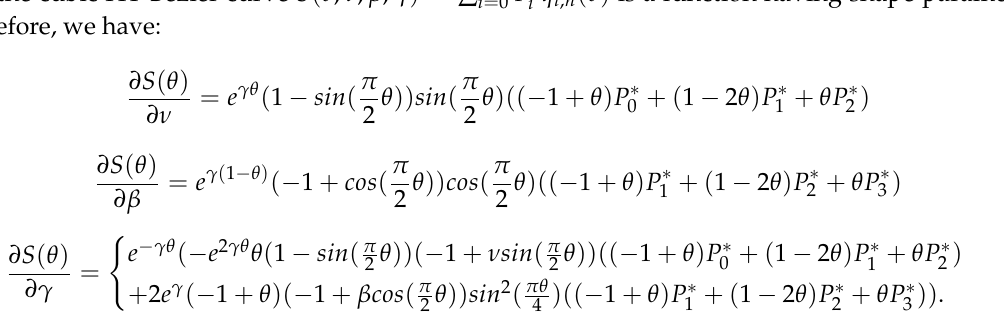
Figure 2. Cubic HT-Bézier curves with distinct shape parameters. ( a ) ν = ( 0.95,0.5, 1, β = 0; ( b ) ν = ( 0.5,0,0.5,1 ) , γ = 0.5, β = 0; ( c ) γ = µ = ( 0, − ( 0,0.5, 0.5, 1 ) , ν , = 1, β = − −